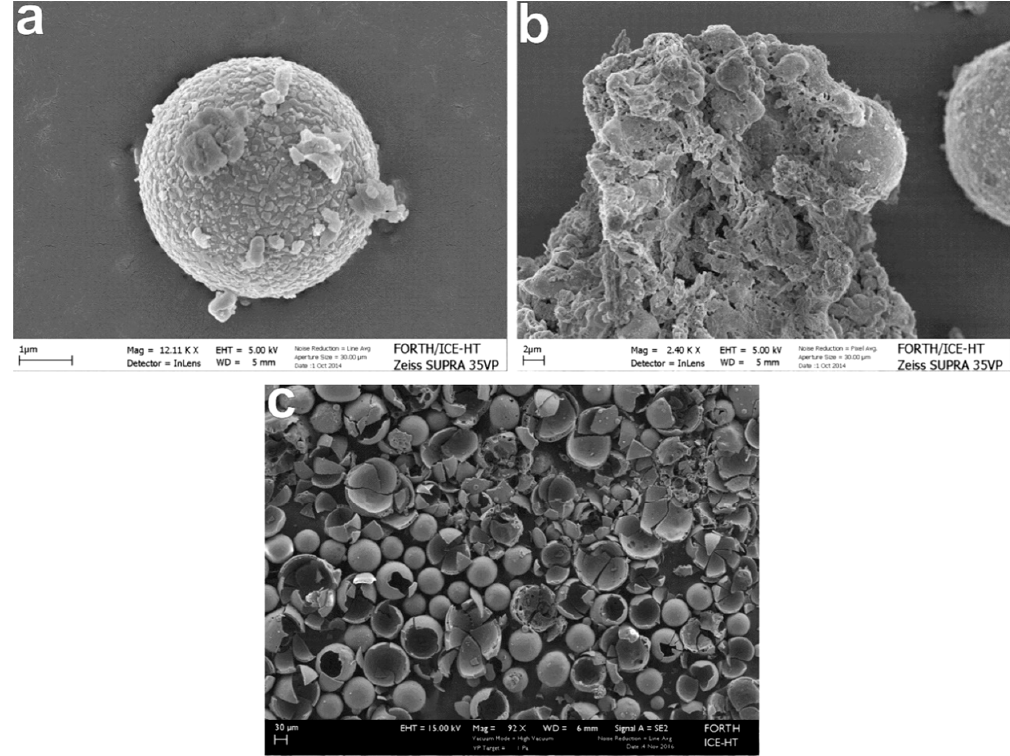
Figure 8. Fly ash particles from a Kardia power plant: ( a – c ): Cenospheres after releasing their gases, silica-coated perfect sphere, and with smaller particles on its surface.